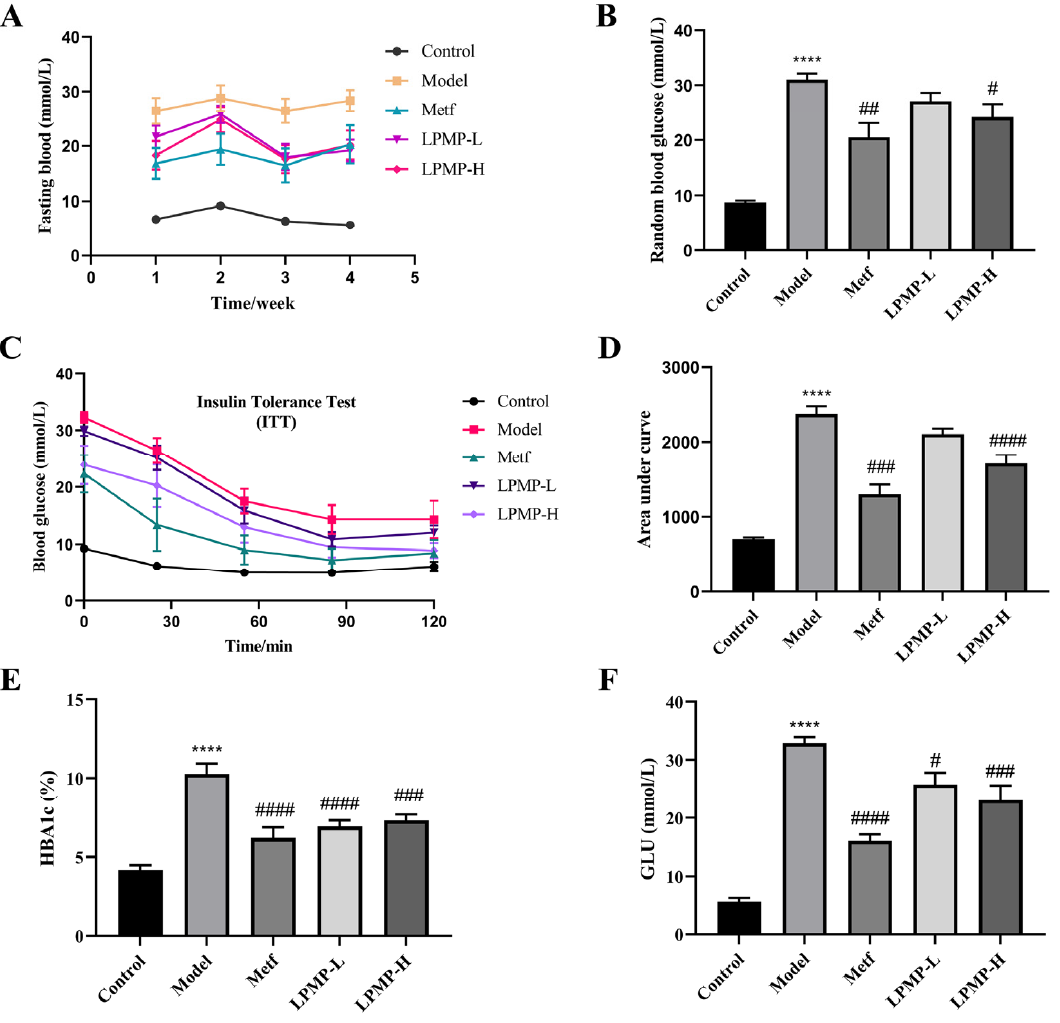
Figure 8. Effects of LPMP treatments on ( A ) fasting blood glucose levels, ( B ) random blood glucose levels, ( C ) insulin tolerance test, and ( D ) areas under the curve of insulin tolerance test of each group in diabetic mice. ( E ) HbA1c and ( F ) glucose concentrations. These results shown are means ± SEM ( n = 8). **** p < 0.0001 versus control group; # p < 0.05, ## p < 0.01, ### p < 0.001, #### p < 0.0001 versus model group.